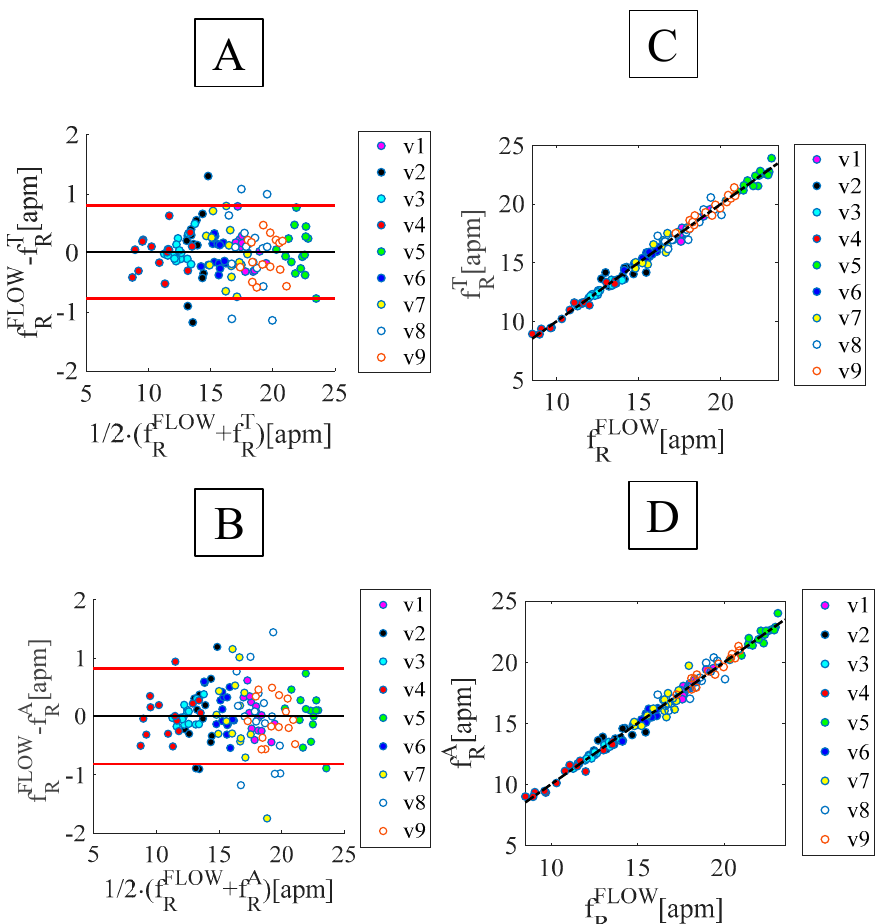
Figure 5. Breath-by-breath analysis: ( A ) and ( B ) Bland-Altman plots using the FBGs placed on the umbilicus, FBG A and xiphoid process, FBG T , ( C ) and ( D ) linear regression of the results obtained by the FBGs placed on the umbilicus -FBG A - and xiphoid process -FBG T - vs. the reference system. Table 2. Performance of the smart textile in respiratory monitoring: results of Bland-Altman analysis, linear regression and MAPE fR .